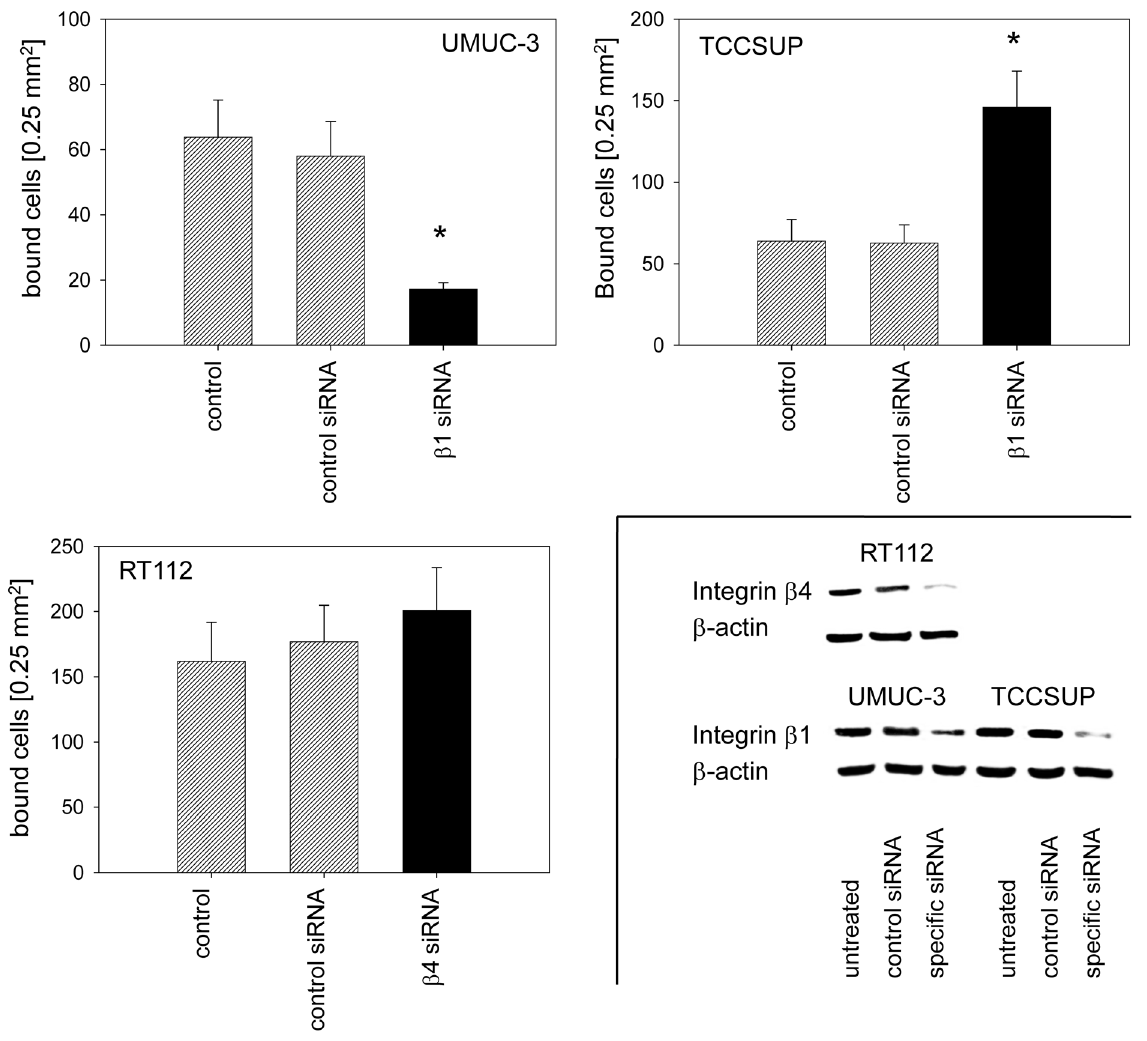
Figure 8. Influence of b 1 (UMUC-3, TCCSUP) or b 4 (RT112) knock-down on bladder cancer cell adhesion to collagen. Tumor cells were transfected with integrin b 1 or b 4 siRNA. Non- treated cells (control) and cells treated with scrambled siRNA (siRNA control) served as controls. Efficacy of receptor knockdown was evaluated by western blotting (lower right). One representative of six experiments is shown. *indicates significant difference to the controls.